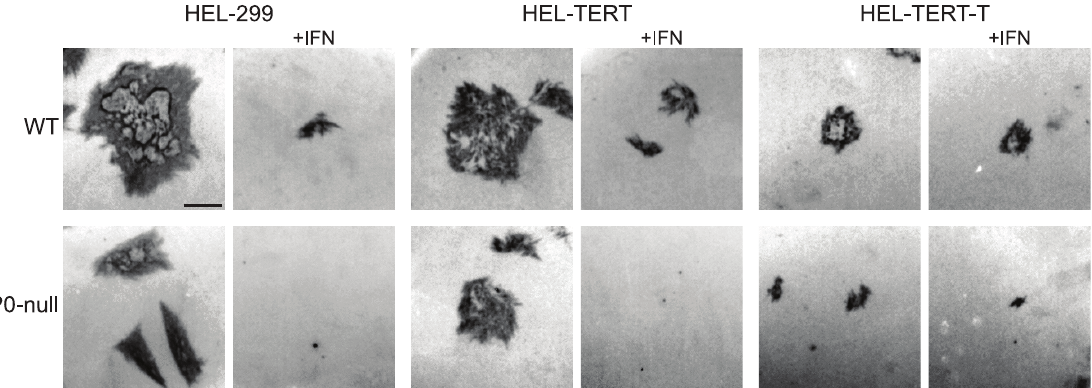
Figure 6. HSV-1 shows similar plaque size and morphology on HEL-299 and HEL-TERT cells. HEL-299, HEL-TERT, and HEL-TERT-T cells were mock or pretreated with IFN- b for 16 h and then infected with WT HSV-1 or an ICP0-null mutant, and plaques for both viruses were visualized by immunohistochemistry three days post-infection. Bar=1 mm.